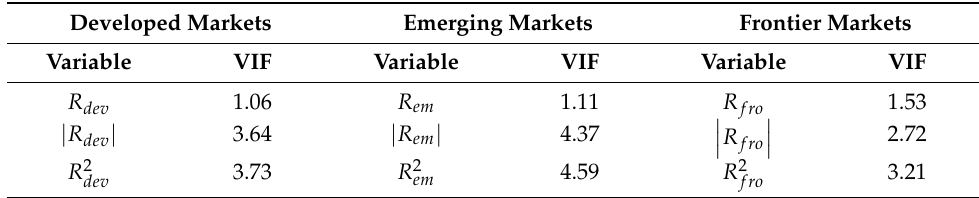
Table 3. Table 3. Variance inflation